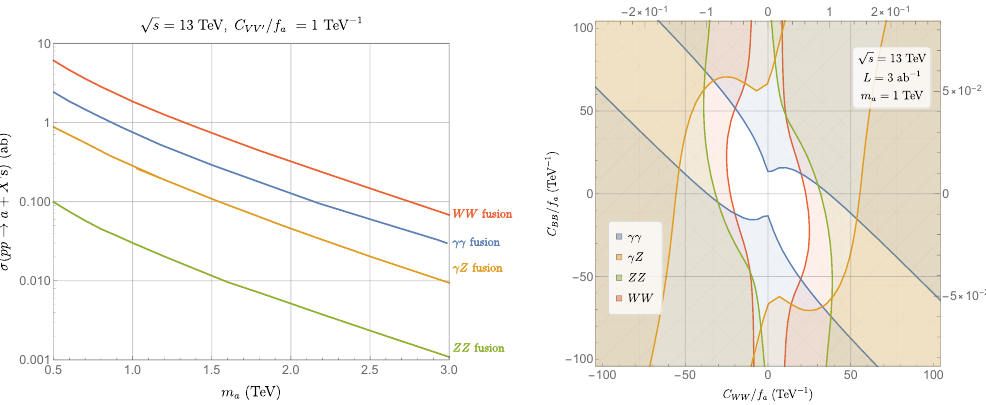
Figure 2 . Left: Different VBF production rates as functions of m a at the 13-TeV LHC, fixing C V V 0 /f a = 1 TeV − 1 . It should be noted that it is impossible to obtain all C V V 0 /f a = 1 TeV − 1 simultaneously since there are only three Wilson coefficients, ( C BB /f a , C BW /f a , C WW /f a ) , before EWSB. Nonetheless, treating γ , Z , and W as partons of protons allows us to show four fusion channels individually as benchmarks. Right: Projected HL-LHC 95% C.L. constraints of C WW /f a and C BB /f a , fixing C BW = 0 and m a = 1 TeV. The bottom and left axes indicate values of the axion couplings defined in eq. (2.1), while the top and right axes indicate another popular EFT convention in